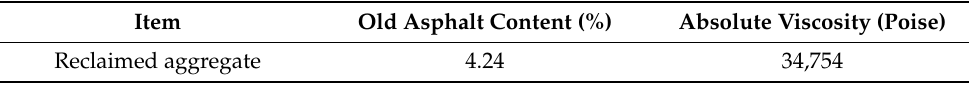
Table 3. Physical properties of reclaimed aggregate.